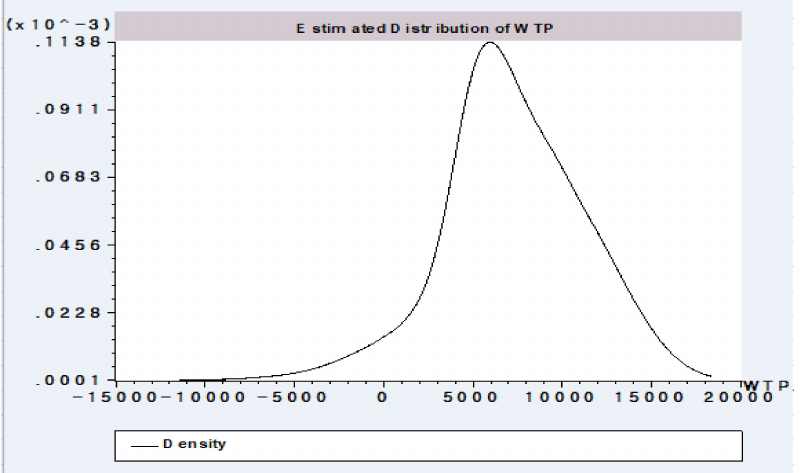
Figure 6. Estimated distribution of each individual’s willingness-to-pay for habitat quality